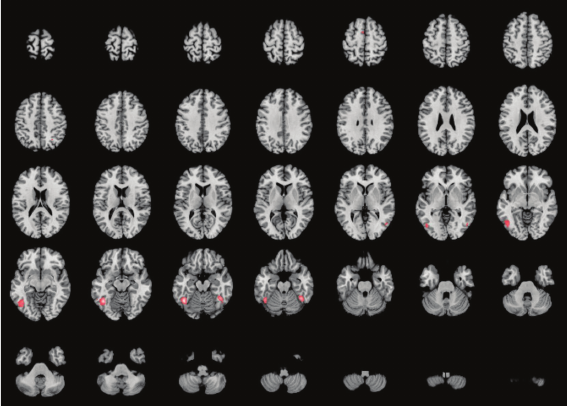
Figure 3: Conjunction analysis of BA37—language and visuospatial networks. Brain anatomical template and orientation are the same as priorly described. Intensities correspond to ALE scores. Color coding range from red (ALE score 0.01) to white (ALE max = 0.039). Mainactivationsaremostlylocatedinthefusiformgyriandadjacent lateral areas of the left side. A small cluster is observed in the left SMA (inset 5 in first row). This cluster however did not pass the volume threshold (vol = 48 cubic